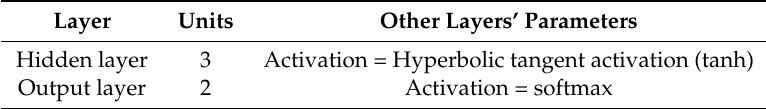
Table 3. Parameters used for all the layers of the proposed SNN